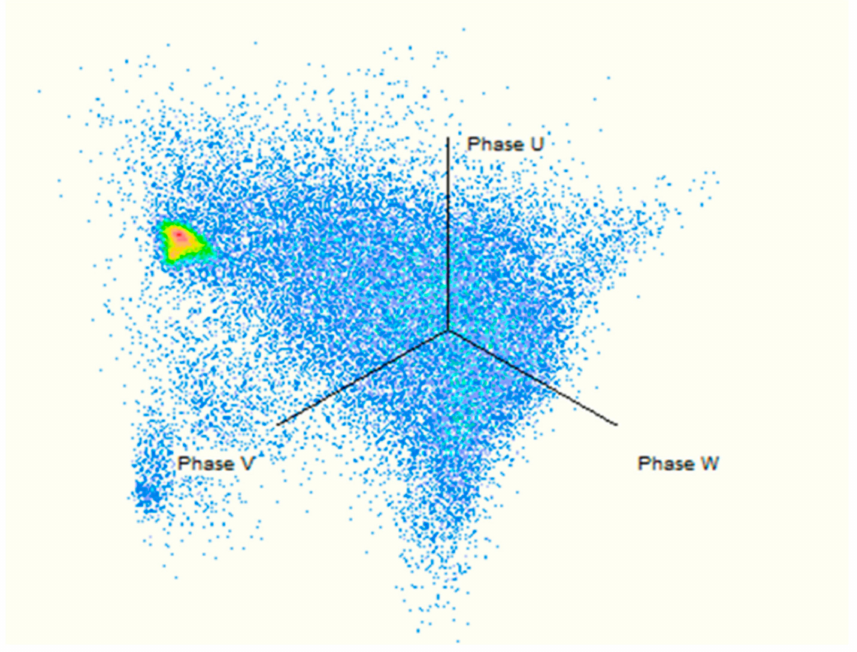
Figure 13. Different locations for PD (3PARD). Table 9. Induced voltage test with PD measurement (IVPD), after oil terminated. Induced Voltage (kV)—150